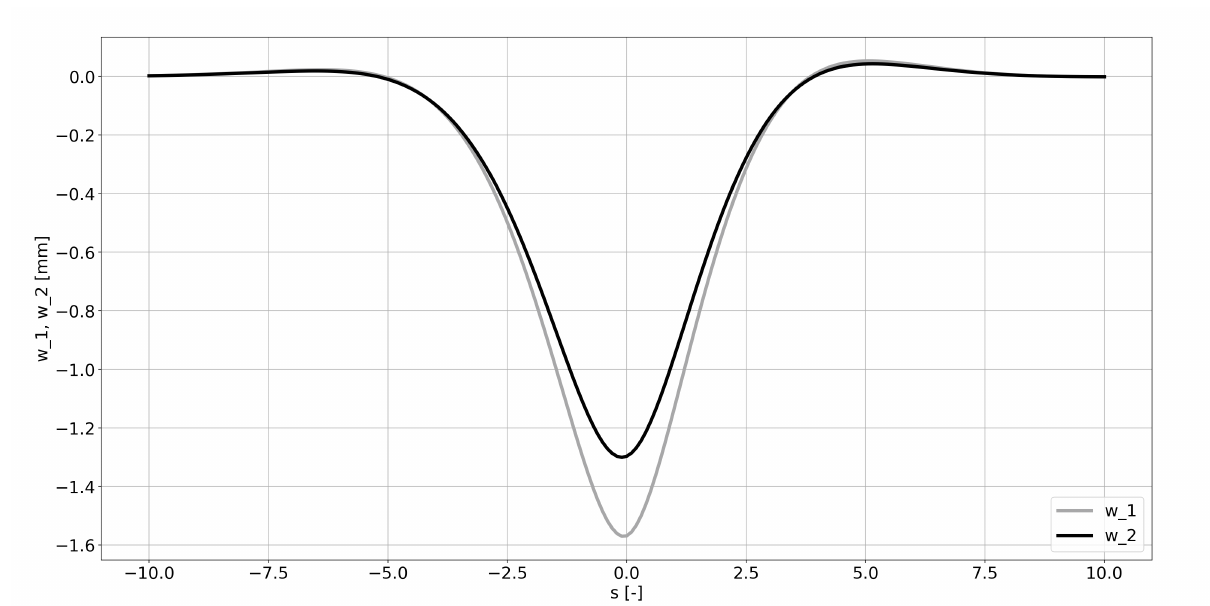
Figure 2. Output of the two-layer model.